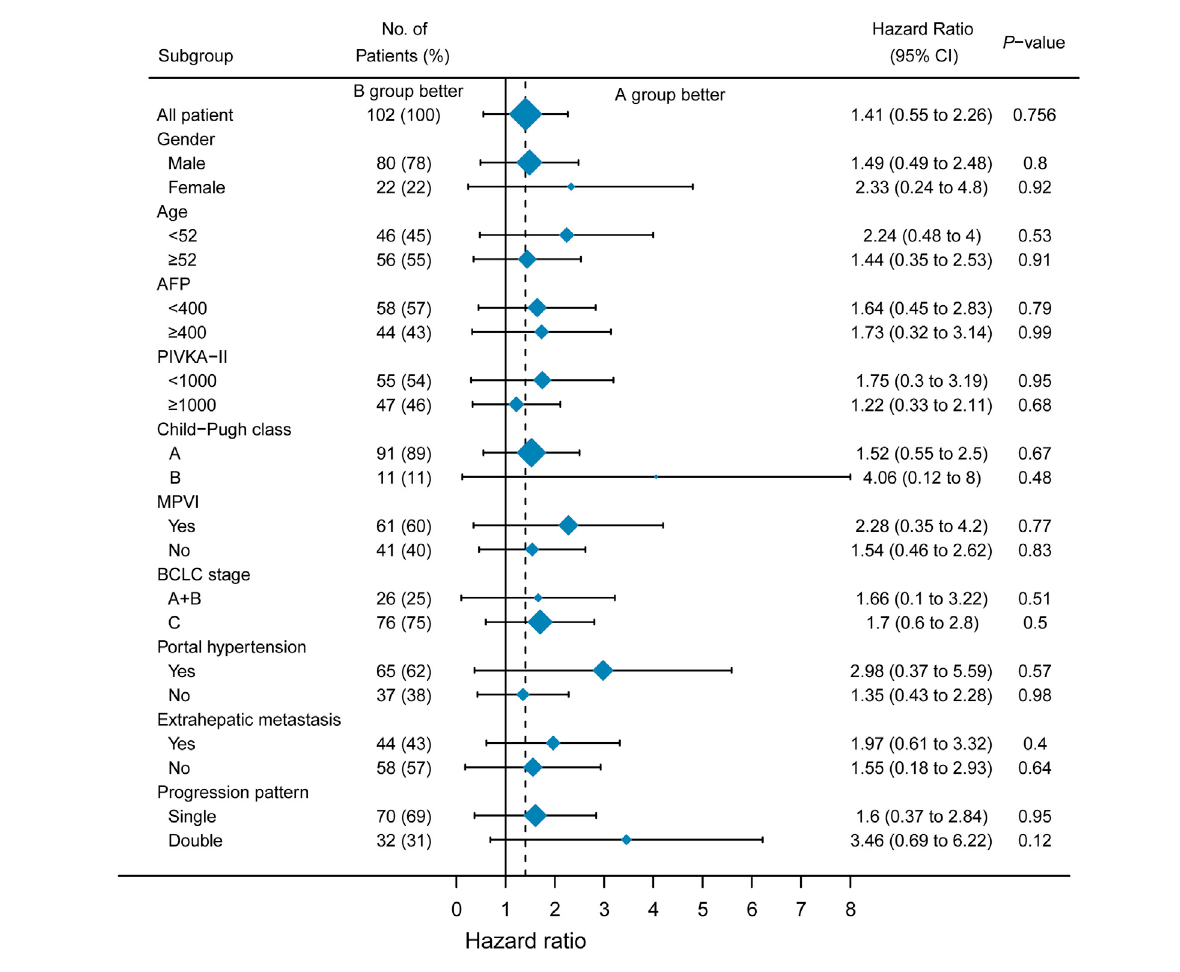
FIGURE 4 Subgroup analysis of second overall survival. MPVI, macroscopic portal vein